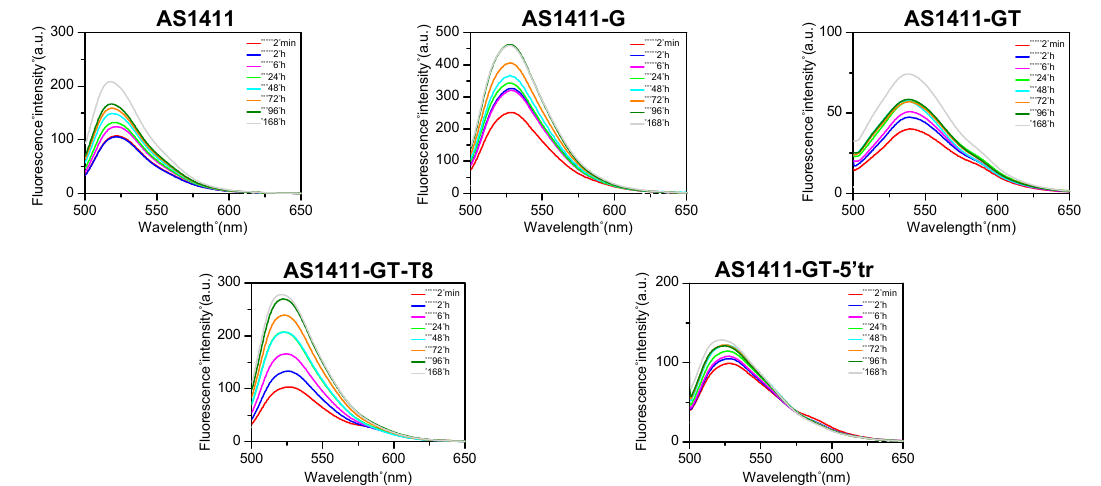
Figure 5. Time dependent fluorescence emission spectra of FAM/TAMRA-labelled GROs (0.1 µM) in the presence of 10% FBS (from 2 min to 168 h of incubation at 37 °C).